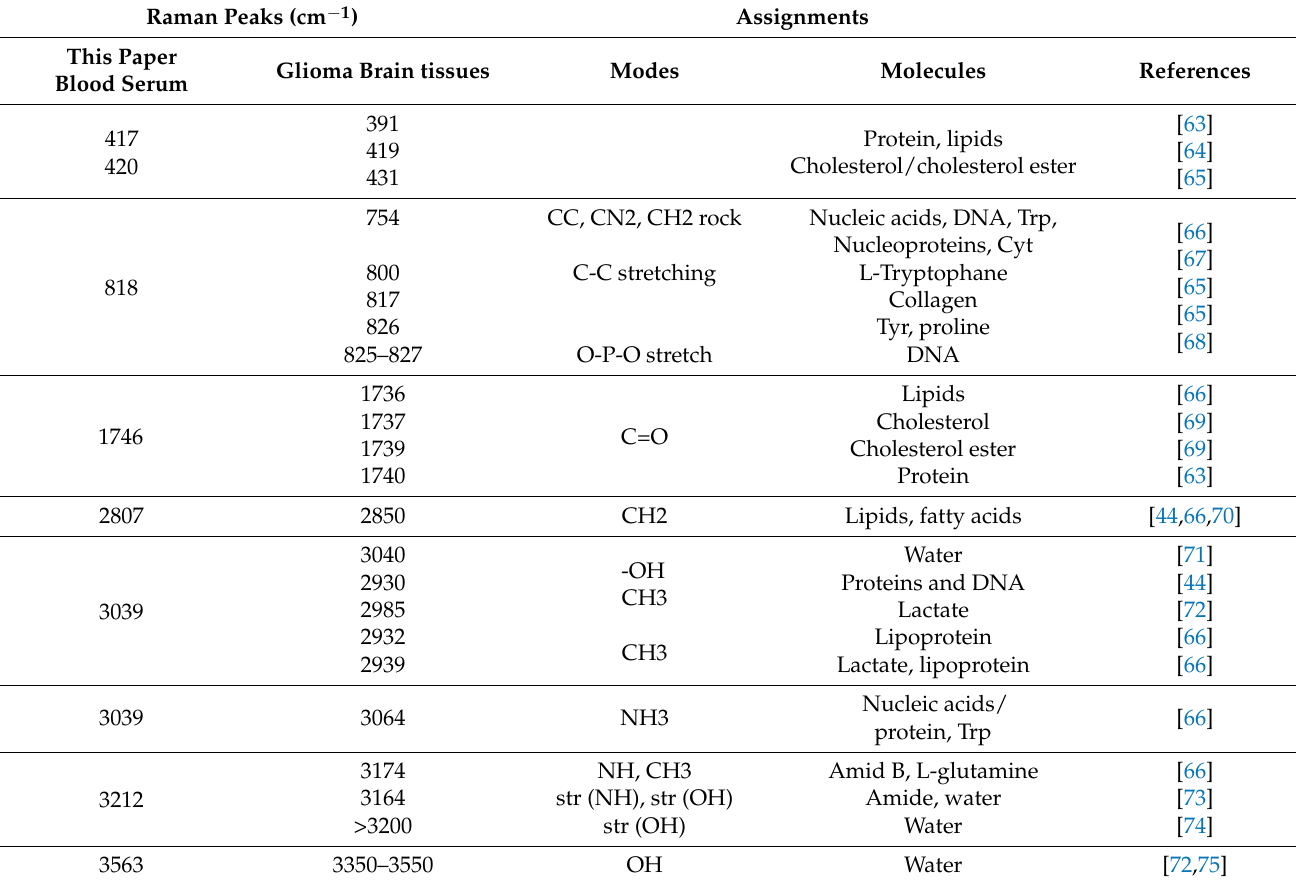
Table 3. Raman spectral peak position and assignments of molecular